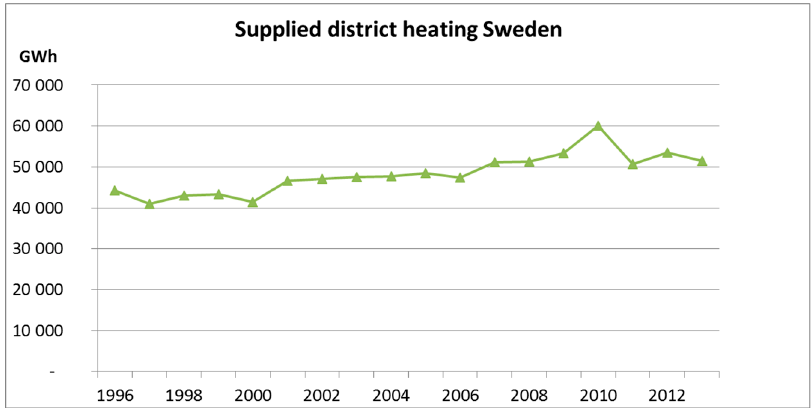
Figure 1. Supplied district heating in Sweden. The growth period for the district heating market is coming to an end and is moving into a period of maintenance. [2] .